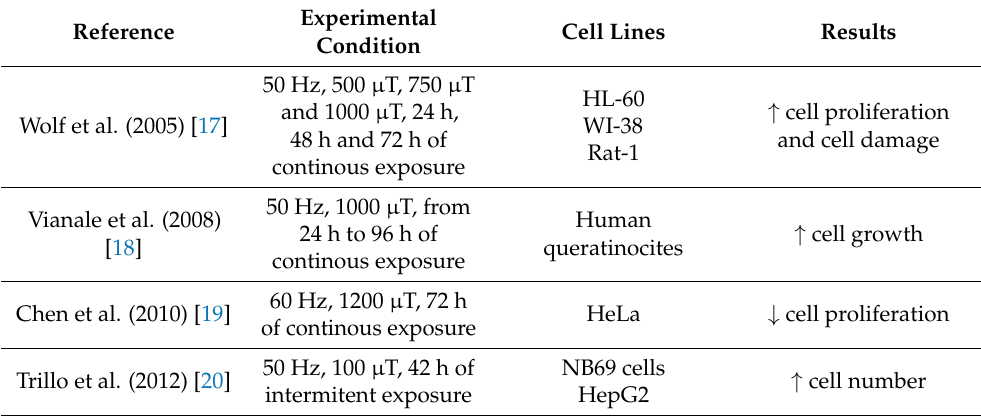
Table 1. Summary of results obtained in the past 15 years with tumoral, and non-tumoral cells lines exposed to different extremely low frequencies (ELFs)